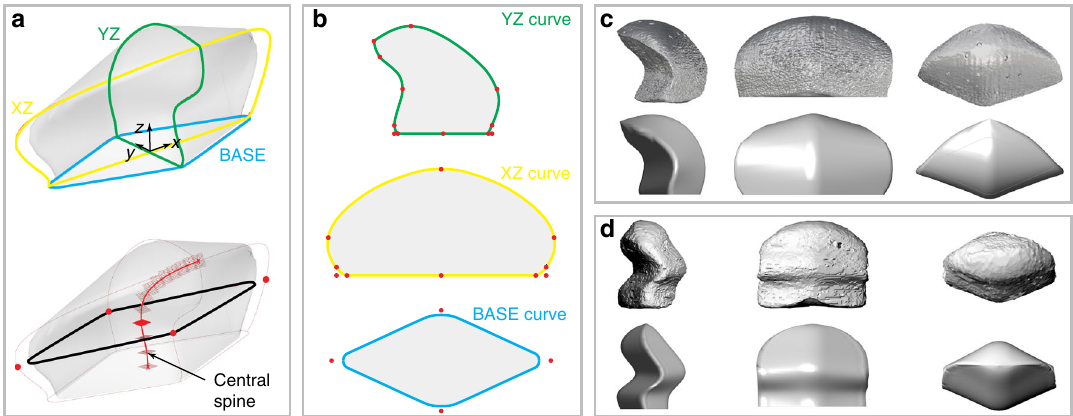
Fig. 5 Three-dimensional parametric modeling of chiton scale geometries. a Top, the 3D scale model with three principal scaffolding curves, XZ, YZ, and BASE. Bottom, 3D scale model highlighted with the central spine for generating the surface meshes. b Three principal curves with geometrical landmarks indicated. c , d Comparison of the original chiton scales with corresponding mimicked scale models for two species: c a single-curved scale from chiton Rhyssoplax canariensis and d a double-curved scale from chiton Lepidozona